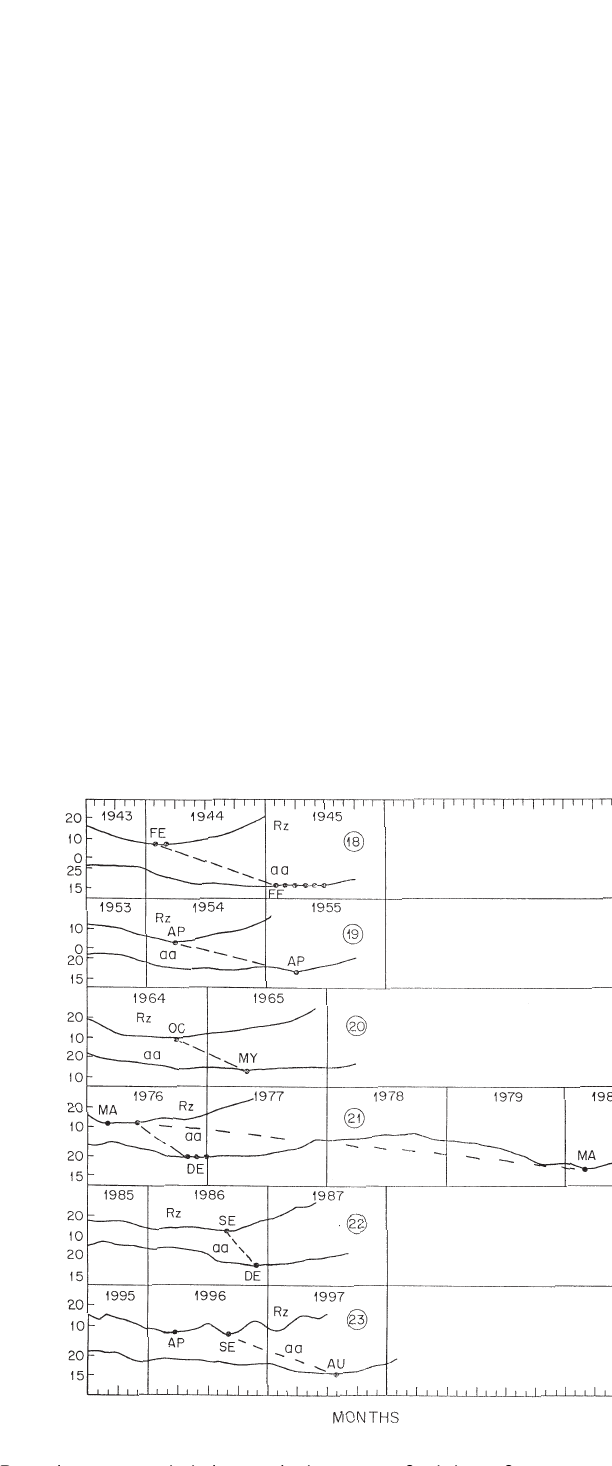
DE) are indicated and the minima of Rz and aa are con- nected by a dashed line. In cycle 14, aa (min) occurred in November 1900, several months before Rz (min), which oc-